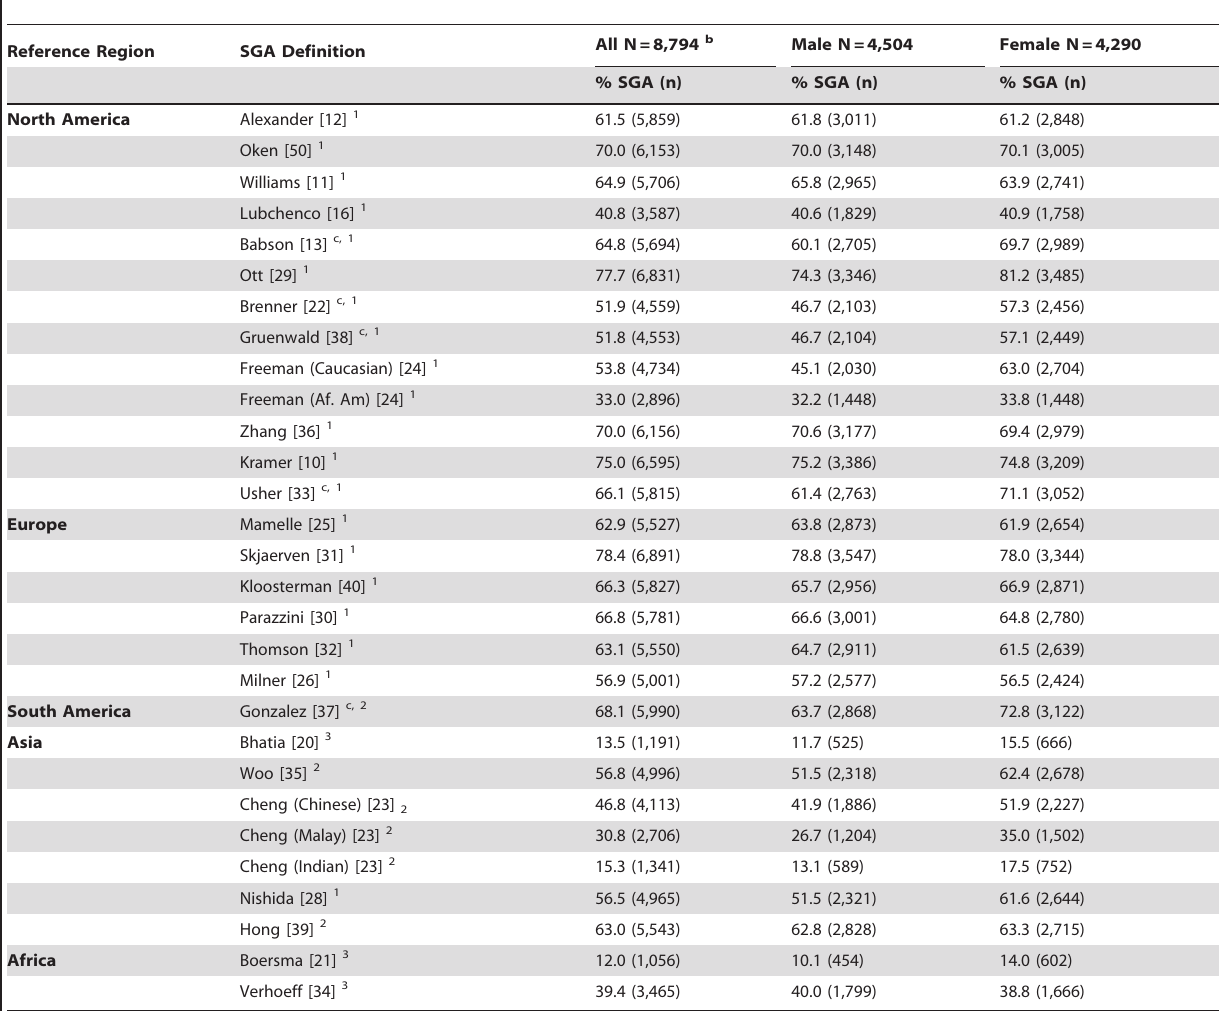
Table 3. Prevalence of Small-for-Gestational Age (SGA) in South India using Reference Populations from Five Regions [18] a .